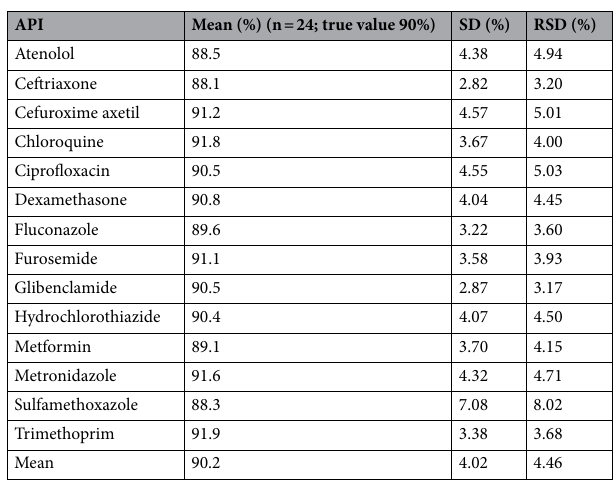
Table 3. Intermediate precision of the quantitative determination with the TLCyzer app. The results of all 336 individual measurements are listed in Supplementary Table S3.